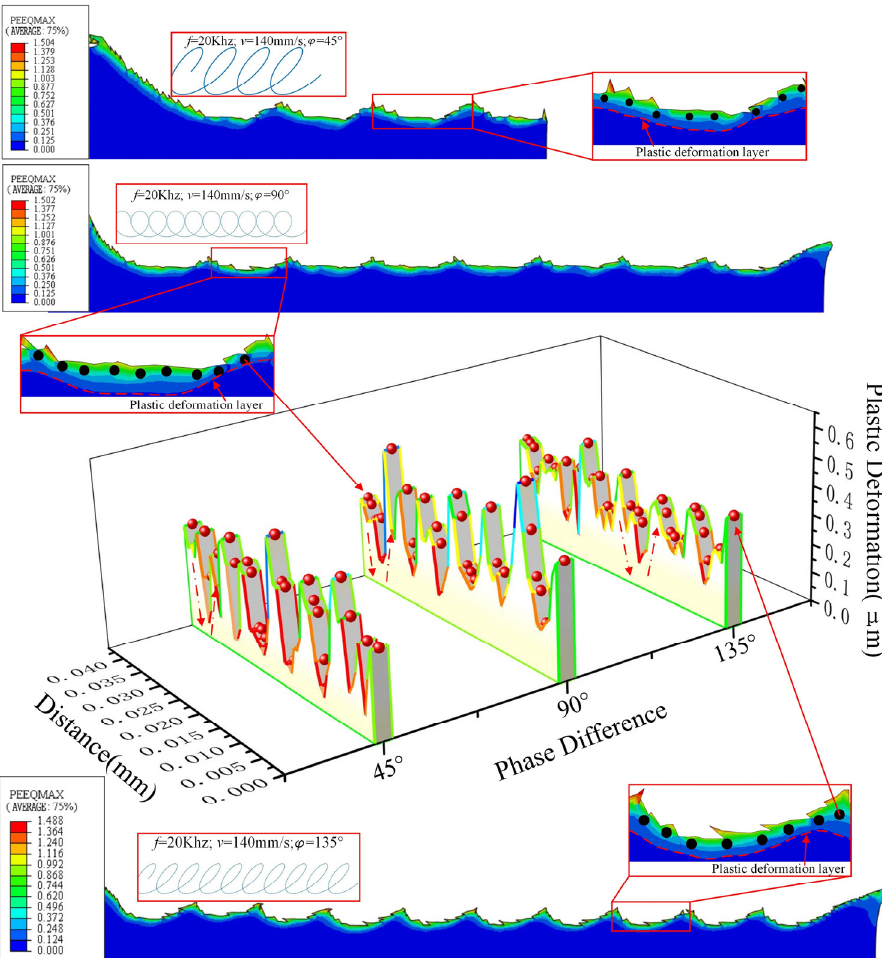
Figure 14. Evolution of surface plastic deformation of UEVC materials.